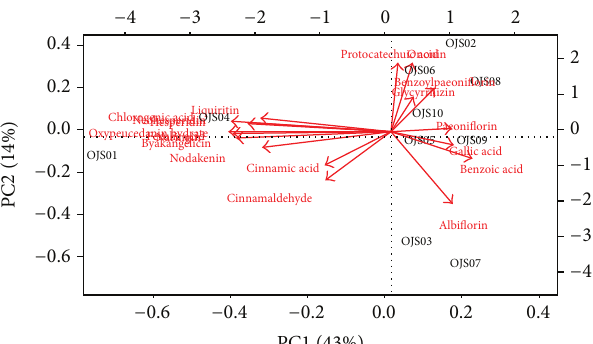
Figure 4: Biplot of the principal components (PC1 versus PC2) of the variables (the contents of the 19 marker compounds) with the objectives(OJSsamples).Theeffectofthemarkercompoundsonthe distribution of OJS samples is shown by the red-colored arrows. PC1 and PC2 contributed to 43% and 14% of total variance, respectively. OJS01, Ojeok-san water extract from the laboratory; OJS02–OJS10, Ojeok-san granules from Korean manufacturers.